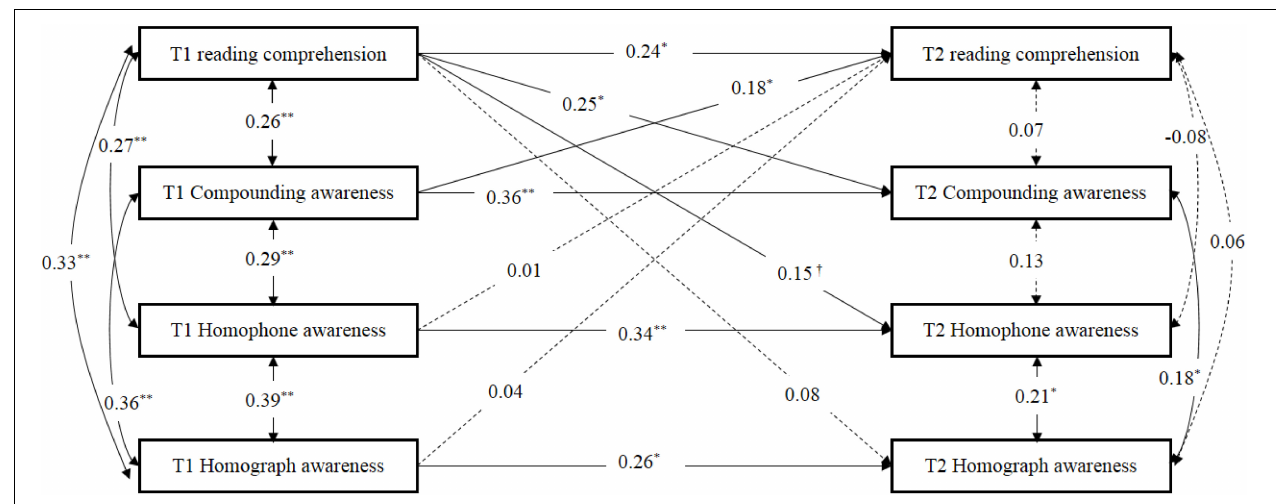
FIGURE 3 | The model to evaluate the longitudinal relationships between compounding awareness, homophone awareness, homophone awareness, and reading comprehension from Grade 5 to 6, after controlling for IQ, rapid number naming, phonological awareness, word reading, and vocabulary knowledge at the initial level. T1, fall of fifth Grade; T2, fall of sixth Grade. Dashed lines indicate non-significant paths. The control variables are not shown here to simplify the representation of the model. † p < 0.08, ∗ p < 0.05, ∗∗ p < 0.01, two- tailed.